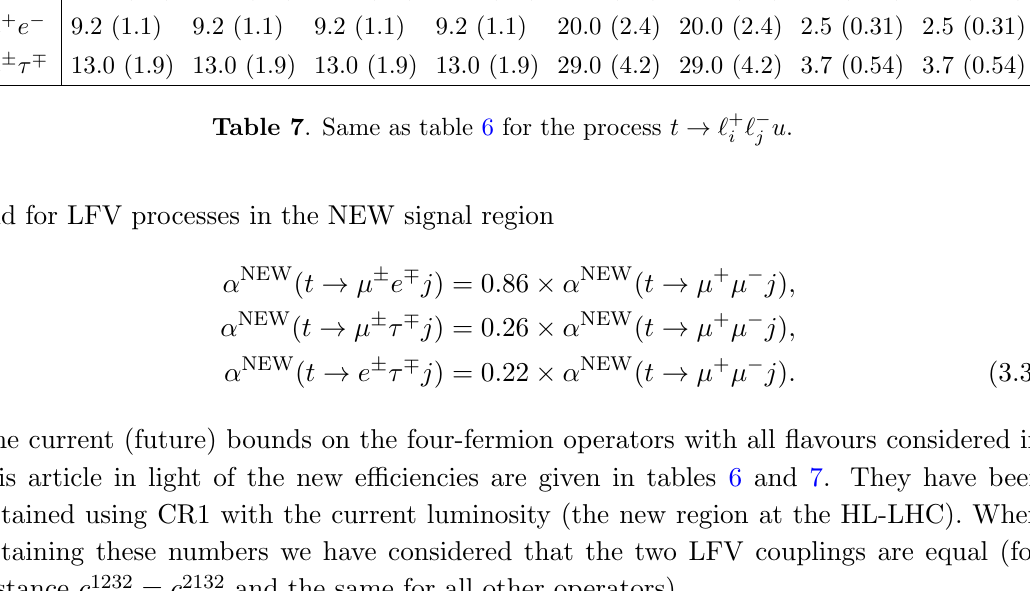
Table 7 . Same as table 6 for the process t